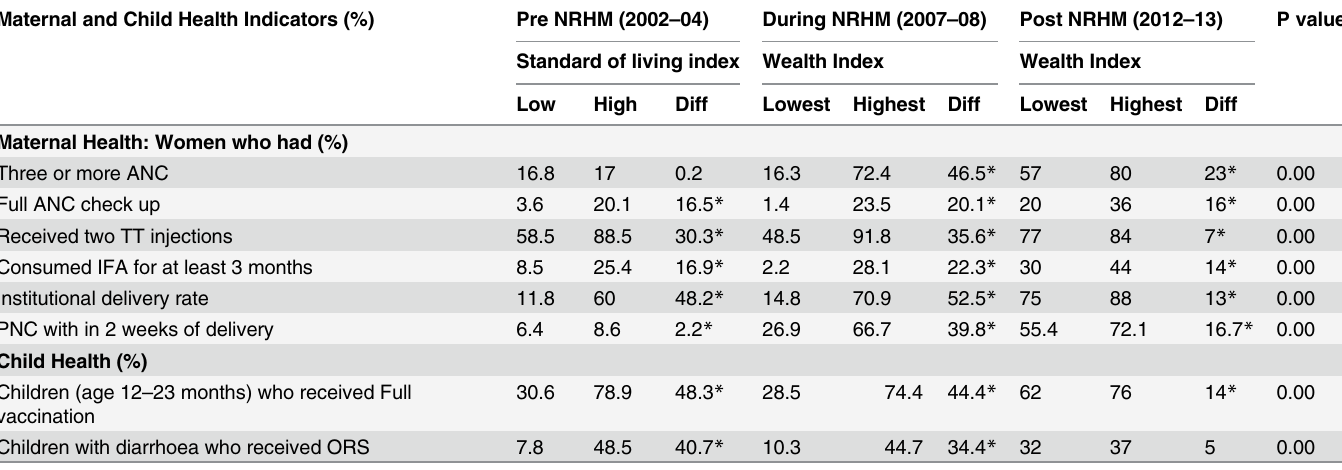
Table 2. Trend of socioeconomic inequalities across various maternal and child health indicators in Haryana from pre to post NRHM. Maternal and Child Health Indicators